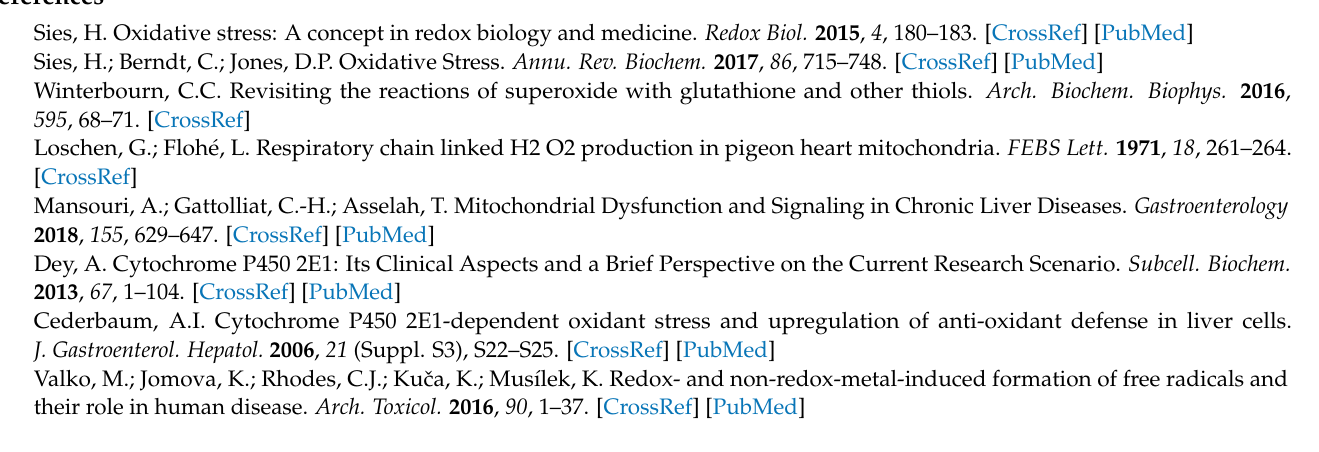
Figure S2, Genotype-specific accumulation of lipid peroxides and oxidative protein damage. Figure S3, GSSG levels measured under alkylating homogenization conditions. Figure S4, Effect of ascorbate treatment on Nrf2-response gene expression in